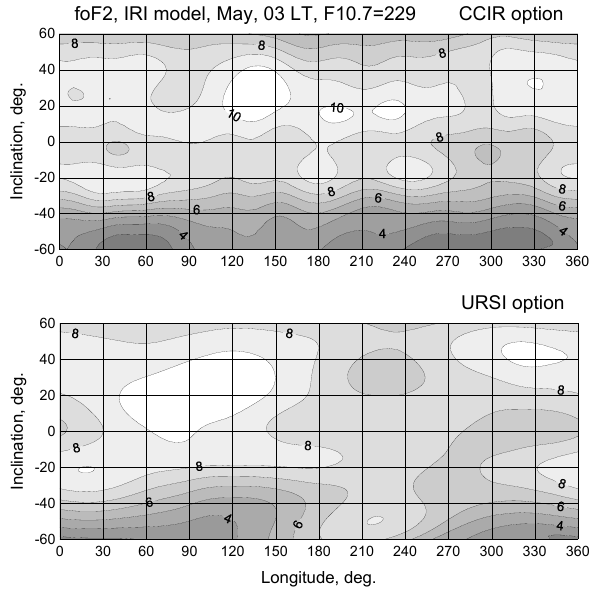
Fig. 8. IRI fo F2 maps with URSI and CCIR coefficients for 02:00 LT in the December solstice.